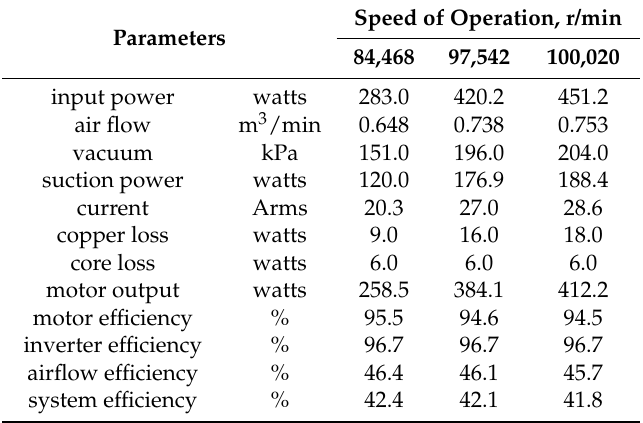
Figure 15. Prototype of single-phase BLDC motor for cordless vacuum cleaner: ( a ) stator and rotor assembly; ( b ) housing structure; ( c ) their assembly. Table 4. Experiment results of the prototype.